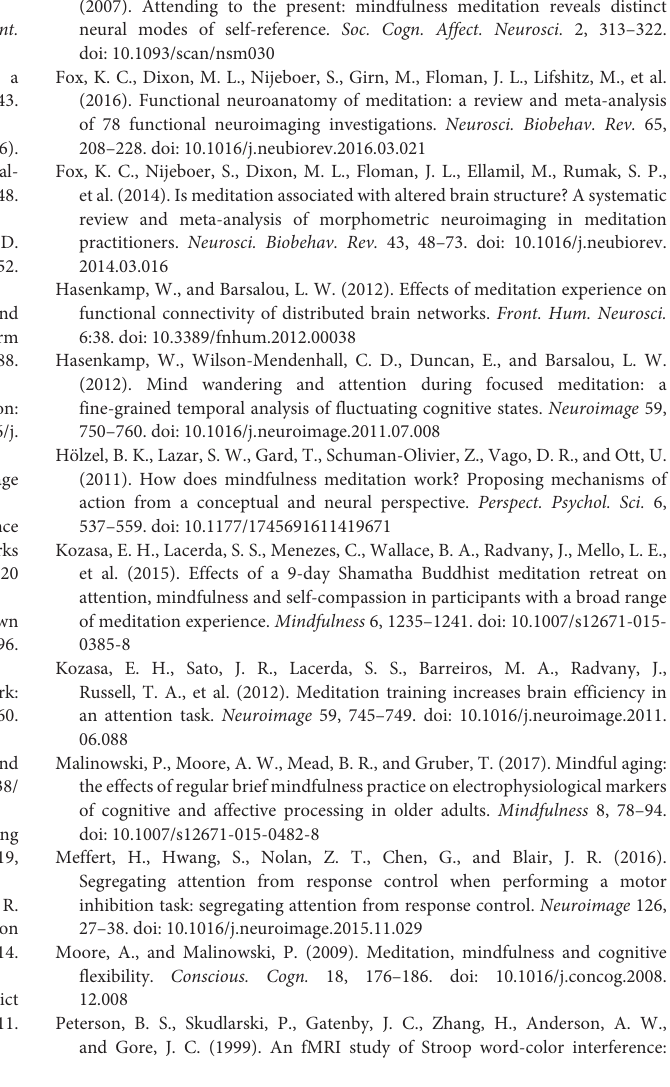
FIGURE S1 | Within group brain activation in meditators and non-meditators. Non-meditators: clusters encompassing posterior cingulate gyrus, caudate, occipital lobe and frontal pole presented reduced activation after the retreat. Meditators: clusters encompassing middle frontal gyrus, parietal lobe, inferior frontal gyrus (IFG) and superior parietal lobule showed reduced activation after the